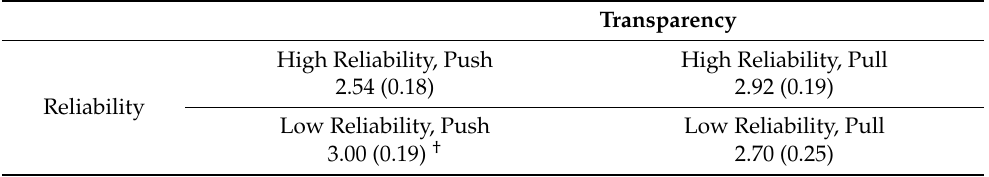
Table 10. Mean and standard deviation of the number of compliances in each